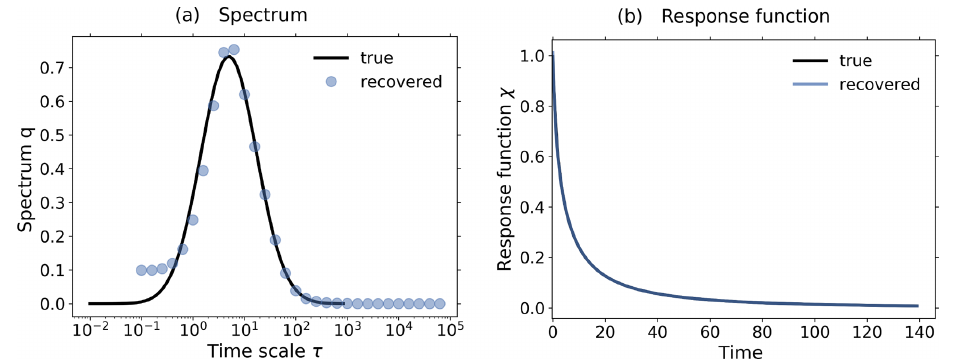
Figure E7. Response function χ(t) and spectrum q λ recovered from toy model data taking the RFI parameters M = 30, log τ min = − 1, and log τ max = 5. Blue dots in (a) and blue line in (b) indicate the recovered values for the spectrum and for the response function, while black lines indicate their “true” values.